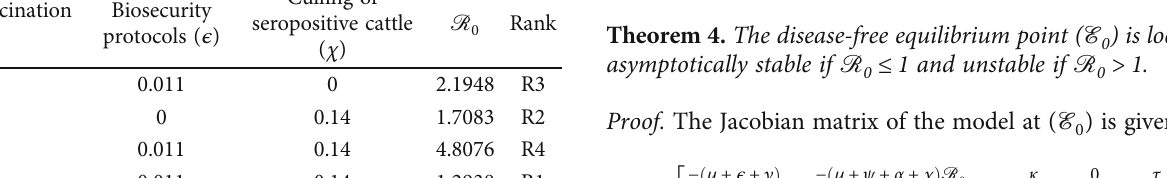
Table 4: Combination of control measures and the ranks of their basic reproduction numbers.